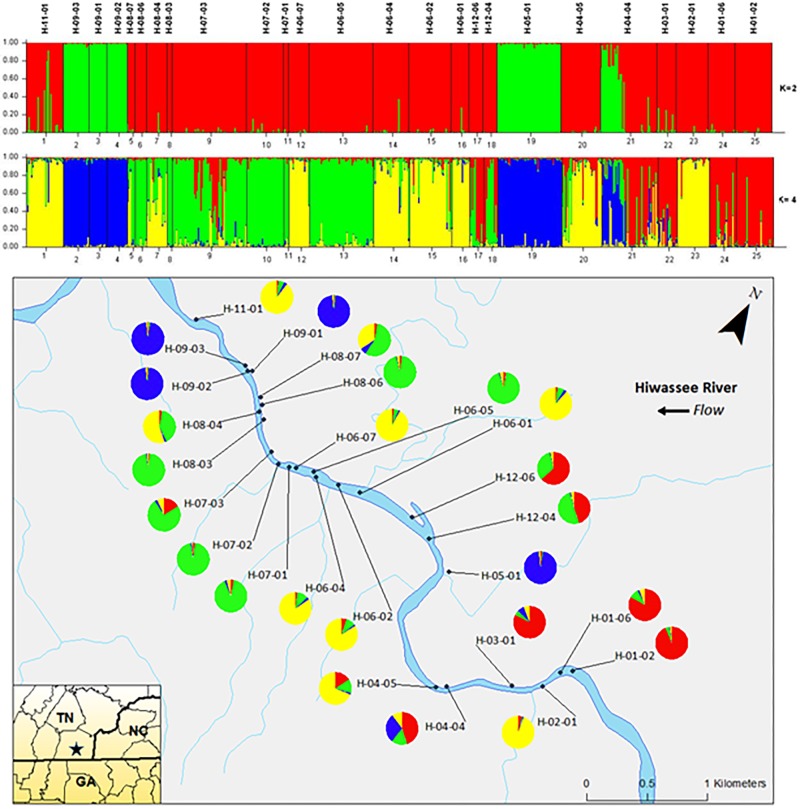
Bar plots of individual Bayesian assignment probabilities of nuclear microsatellites for Pityopsis ruthii Hiwassee River sampling sites using the program STRUCTURE for two or four clusters. Each vertical line represents an individual’s probability of belonging to one of k clusters (represented by different colors) or a combination if ancestry is mixed. Map of the sampled populations. Pie charts correspond to the population assignment for the four genetic groups defined by the Bayesian assignment of STRUCTURE.